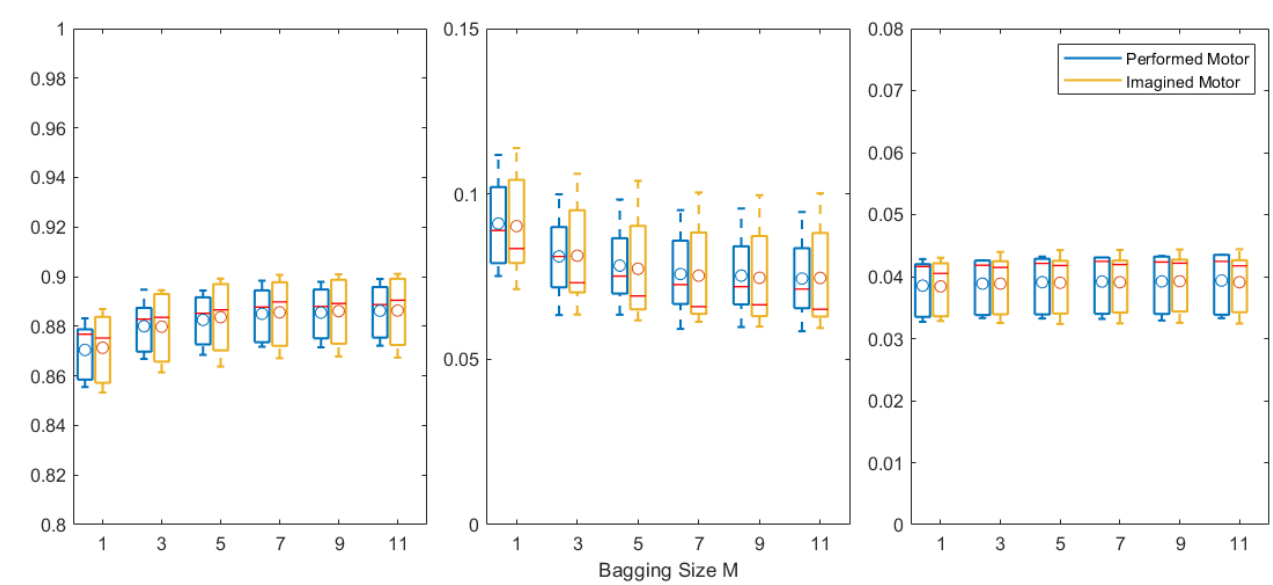
Figure 7. Boxplots of ( left ) accuracy, ( center ) FAR, and ( right ) FRR for performed and imagined motor tasks, plotted as a function of bagging size M. Other conventions are as in Figure 6.